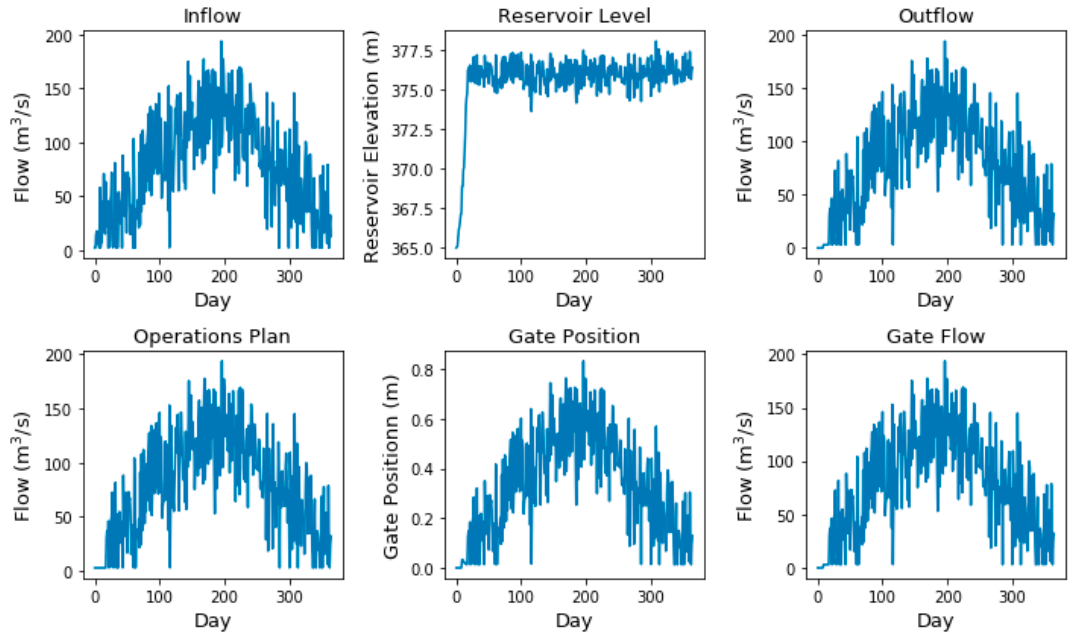
Figure 6. Simulation results for simple dam system with single weir and gate, with operations planning algorithm implemented.